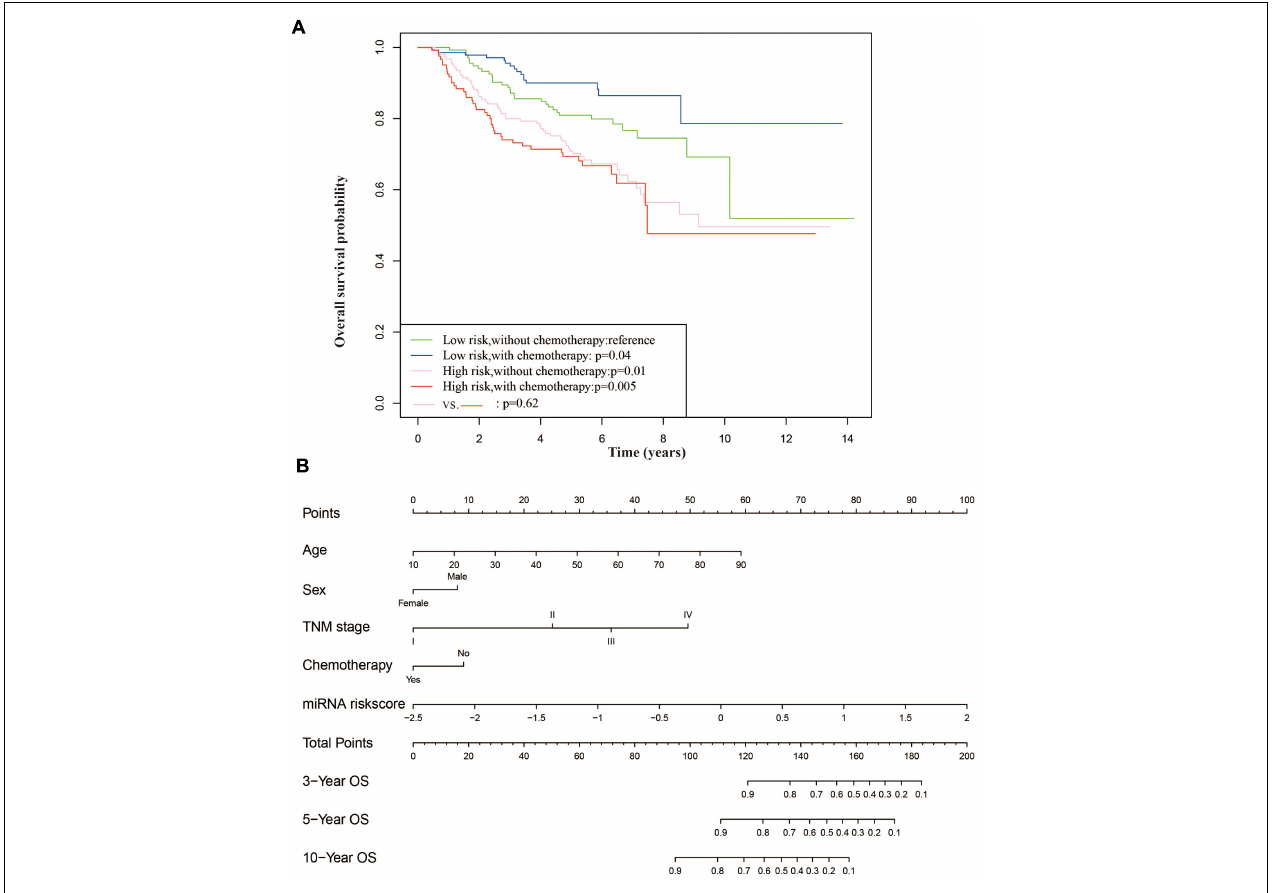
FIGURE 5 | The 6-miRNA risk score could be used to guide chemotherapy and a nomogram for OS prediction based on clinical characterization and 6-miRNA risk score. (A) Survival plots of patient stratified by 6-miRNA risk scores and chemotherapy treatment. Patients in the low-risk group treated with chemotherapy had better overall survival. (B) Construction of a nomogram based on clinical characterization and 6-miRNA risk score to predict the 3-, 5-, and 10-year overall survival of NPC patients. TABLE 2 | Comparison of the survival models without and with 6-miRNA risk score using 558 patients. Without 6-miRNA (only clinical